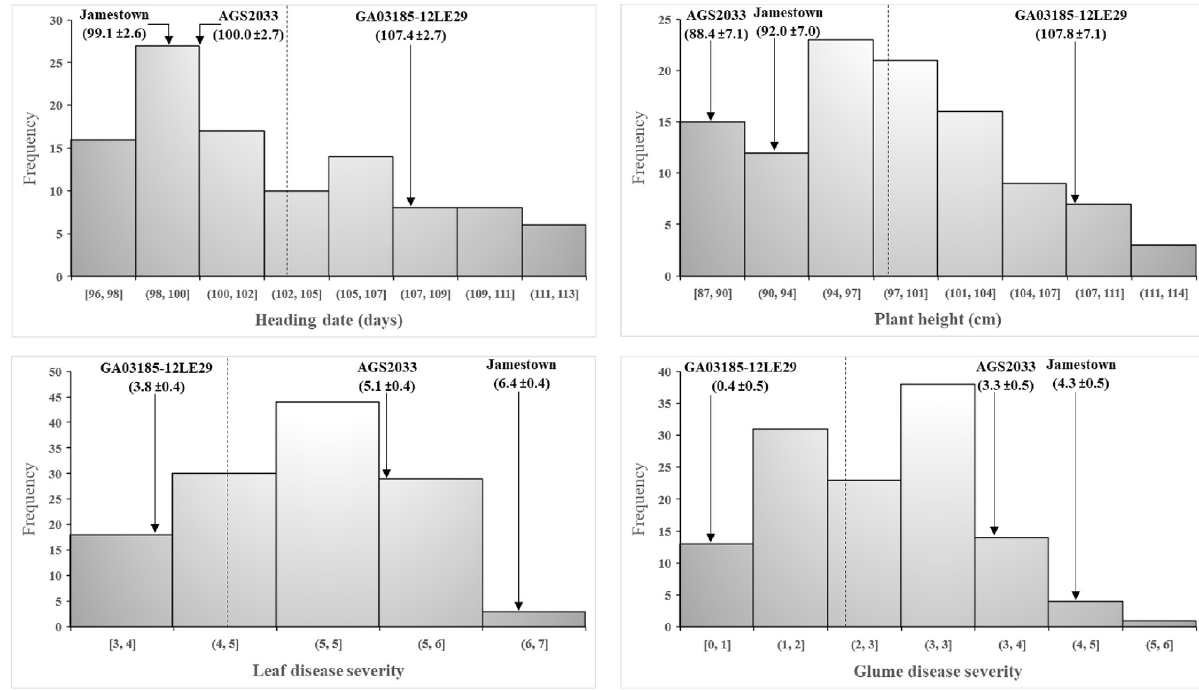
Fig 1. Means across years for parents and DH lines of PH, HD, LS and GS. Dashed vertical line indicates the GADH population mean for each trait. GA03185-12LE29 = moderate resistant parent. AGS2033 = moderate susceptible parent. Jamestown = susceptible control. Disease severity scale = 0–9.